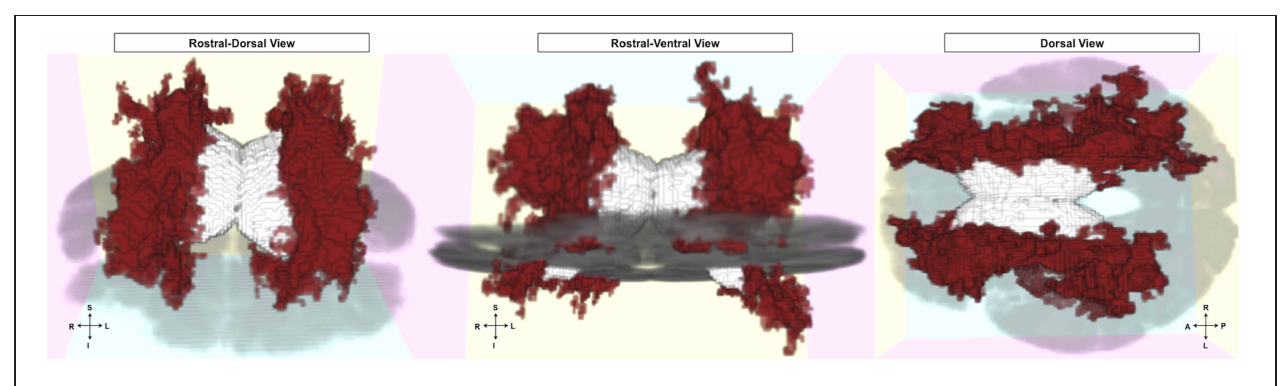
FIGURE 4 | FLAIR clusters significantly related to episodic accuracy among older adults. Presented with left and right hemisphere clusters in red, ventricles in white, and axial